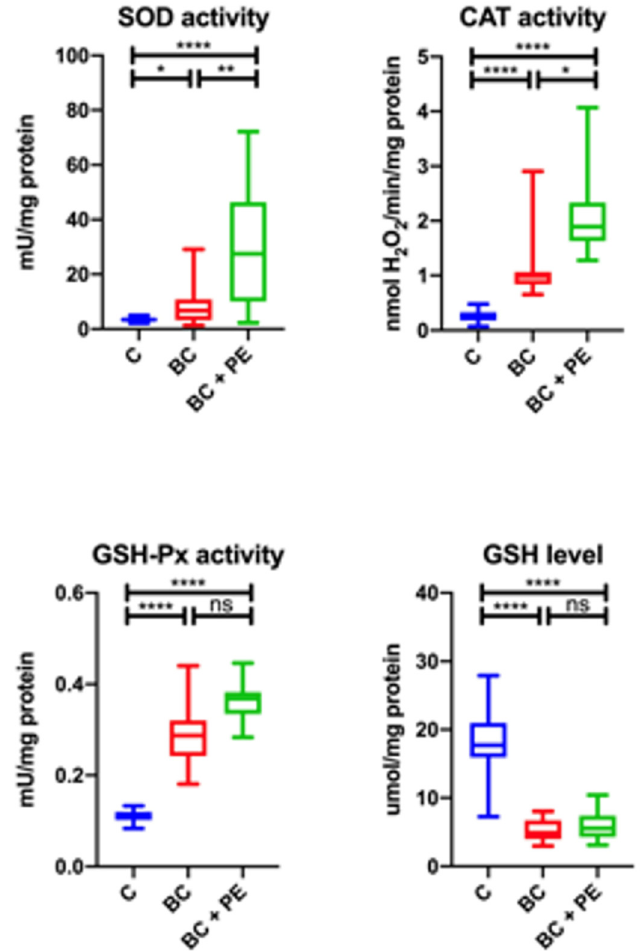
Figure 1. Results for antioxidant enzymes (SOD, CAT, and GSH-Px) and non-enzymatic antioxidants (GSH) in the study groups. * p < 0.05, ** p < 0.01, *** p < 0.001, **** p < 0.0001, ns-not statistically important.